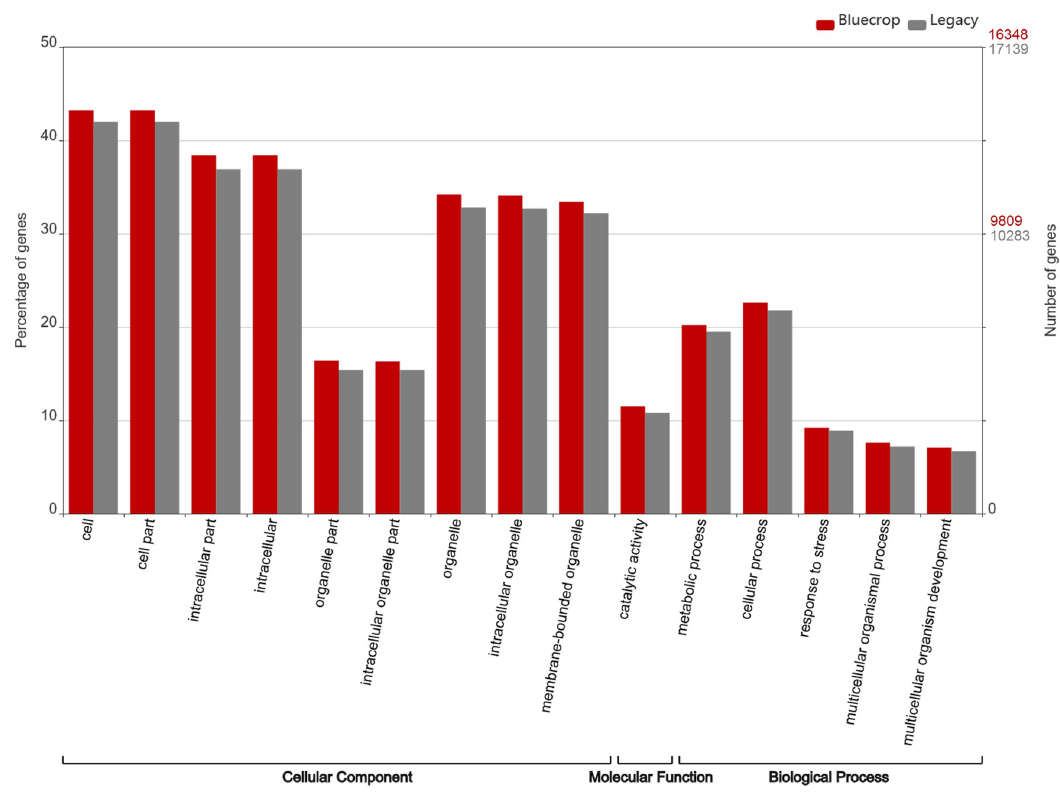
Fig 2. Gene ontology (GO) functional classification of annotated unigenes for ‘Bluecrop’ (red) and ‘Legacy’ (grey) into cellular component, molecular function and biological processes categories. The main y-axis shows the percentage of unigenes annotated whilst the secondary y-axis details the number of unigenes annotated for ‘Bluecrop’ (red) and for ‘Legacy’ (light